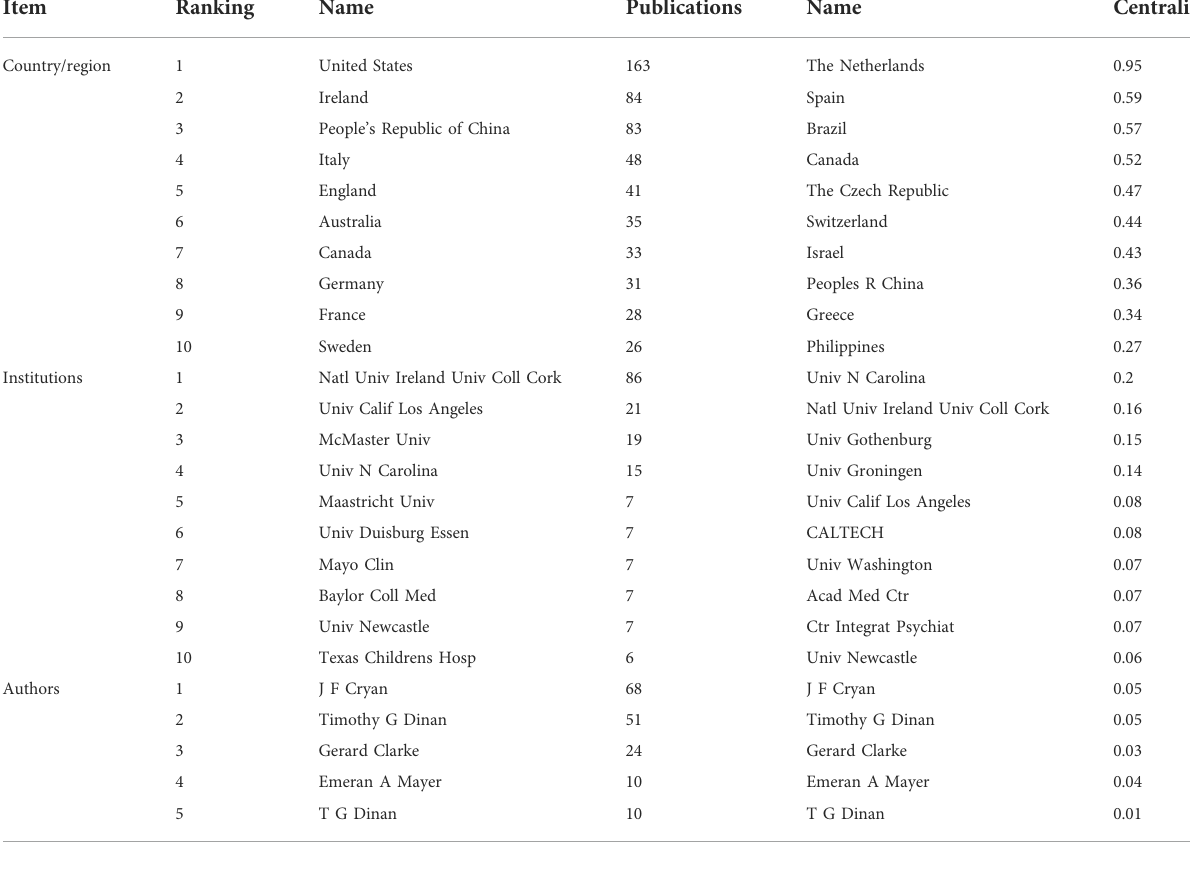
TABLE 1 Countries/regions, institutions, and authors ranked by publications and centrality.